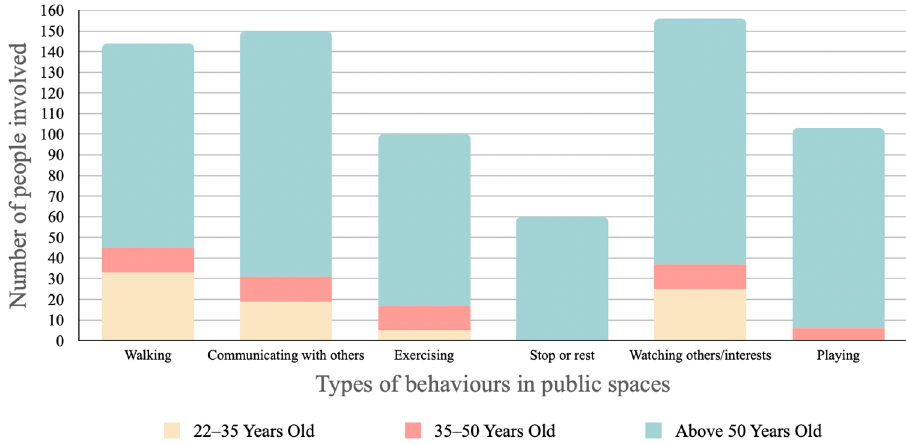
Figure 7. Local cognitions-based behaviours in public space of the neighbourhood.